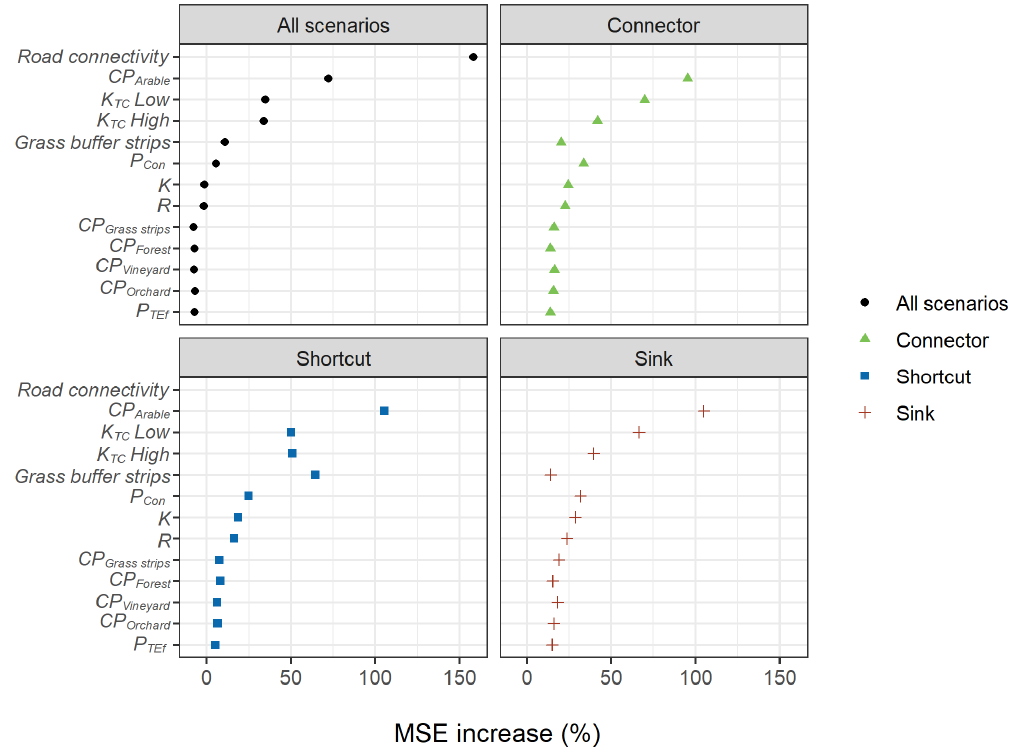
Figure 5. Mean squared error (MSE) increase associated to model input factors for the random forest analysis (RFA). Larger relative errors indicate the input factors were more important for estimating model